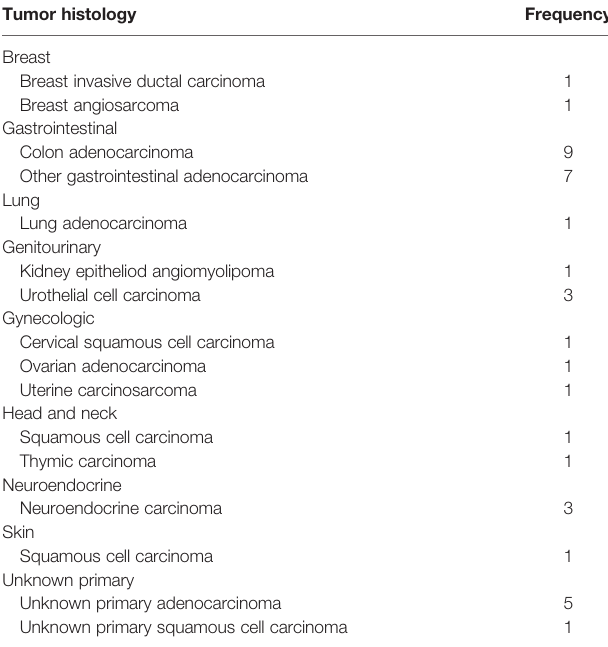
TABLE 2 | Tumor histology.